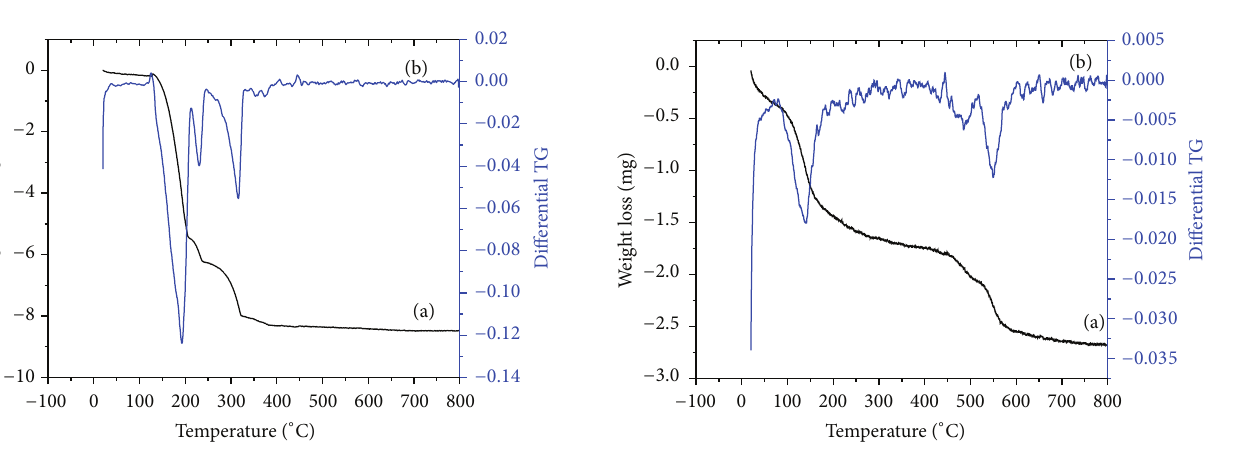
Figure 13: (a) TGA thermograms of KPDM. (b) Differential plot of KPDM.